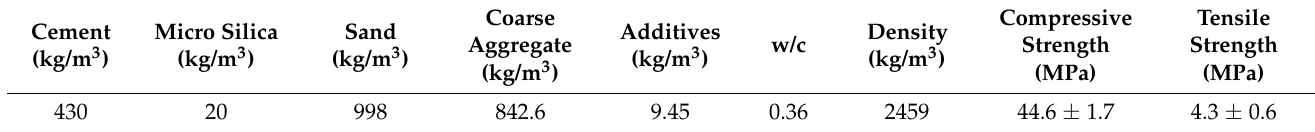
Table 2. Concrete mix proportions and mechanical